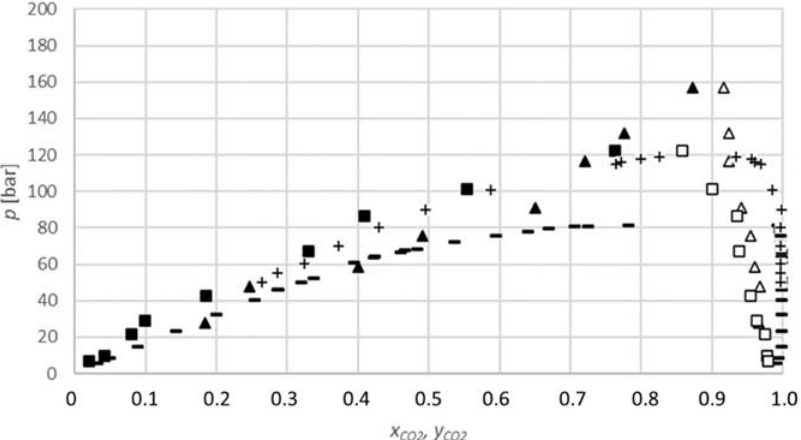
Figure 4. P-x,y diagram for the phase equilibria for the CO 2 -1-butanol binary system ( x CO2 , y CO2 : CO 2 mole fraction): ▲ , measured data at 313.15 K (lower phase); ∆ , at 313.15 K (upper phase); ■ , at 333.15 K (lower phase); ◻ , at 333.15 K (upper phase); − , Secuianu et al. (2004) at 313.15 K [29]; +, Chen et al. (2002) [30].